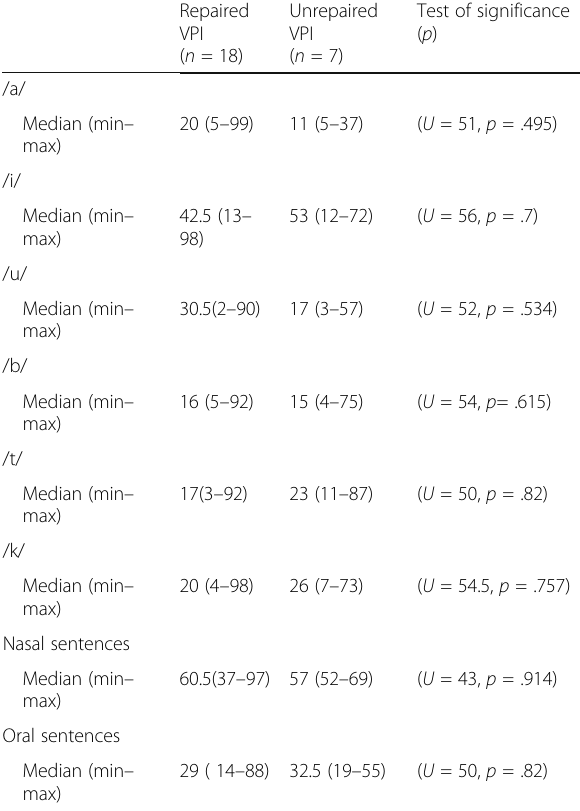
Table 7 Comparison between repaired and unrepaired velopharyngeal insufficiency regarding post-intervention nasometer values